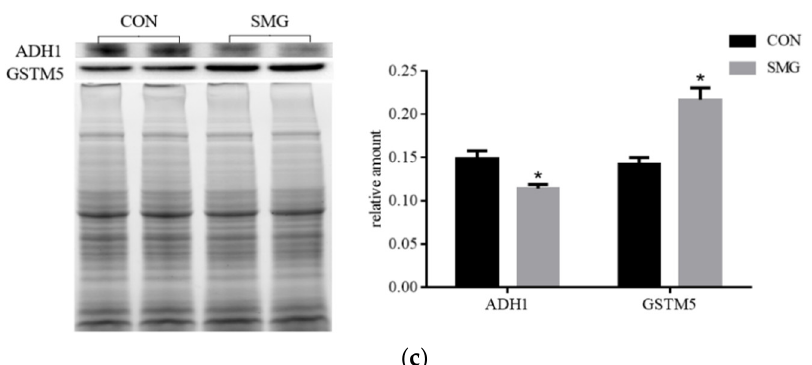
Figure 1. Results of all identified proteins and differentially expressed proteins, and verification by Western-blot. ( a ) Volcano plot of all identified proteins; ( b ) cluster map of all differentially expressed proteins (DEPs) after 14 d simulated microgravity (SMG); ( c ) Western-blot of alcohol dehydrogenase 1 (ADH1) and glutathione S-transferase mu 5 (GSTM5) in rat small intestine under 14 d SMG for verifying the results of MS. Compared with the control group (CON ), * p < 0.05. Compared with 7 d SMG experiments [11], 159 DEPs in 14 d SMG were the same as those in 7 d SMG. The number of DEPs in intestinal mucosa of 14 d SMG treated rats was less than that of in 7 d